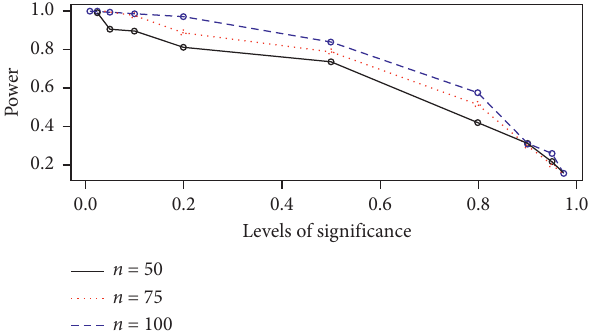
Figure 3: Power results at k � 3 with parameters (0.85, 0.05, 0.1, 0.12, 2.97, 2.92).